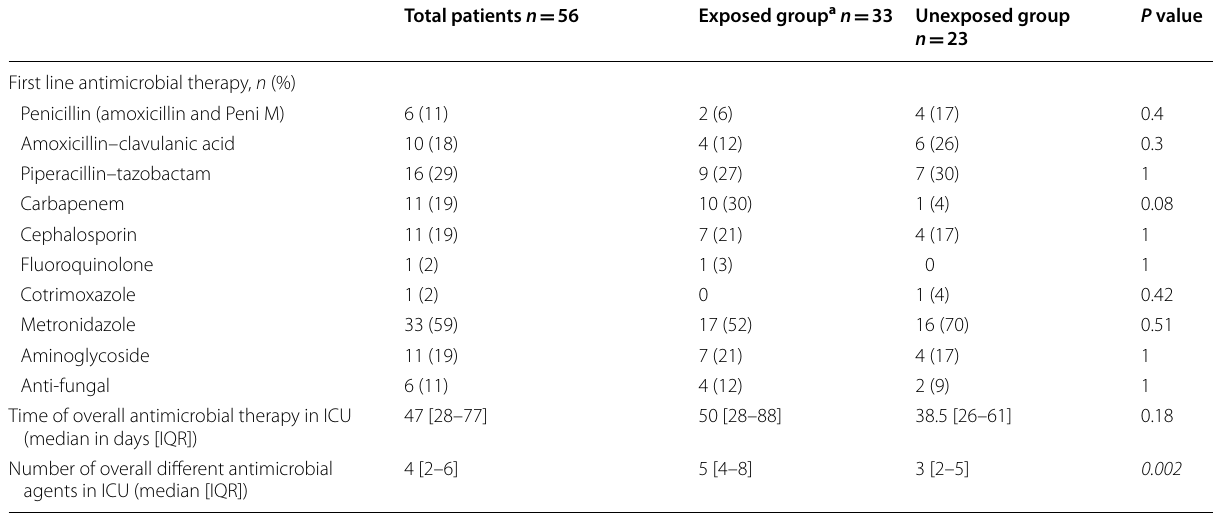
Italic value indicates significance of P value ( P < 0.05) a Exposure was defined as patients who were started on antibiotics more than 24 h before the first pancreatic sample was